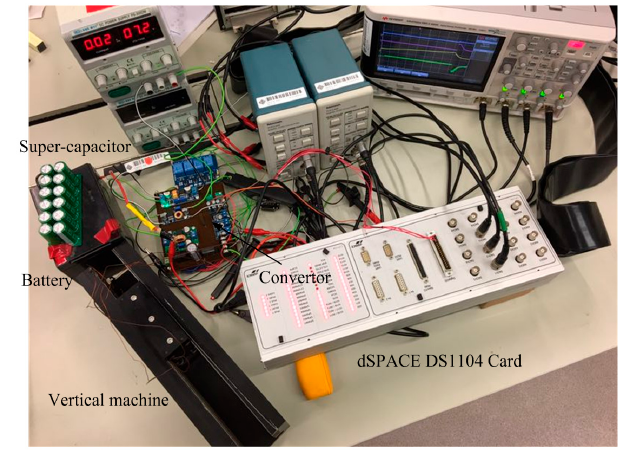
Figure 19. Experimental setup of the generation and energy storage system.